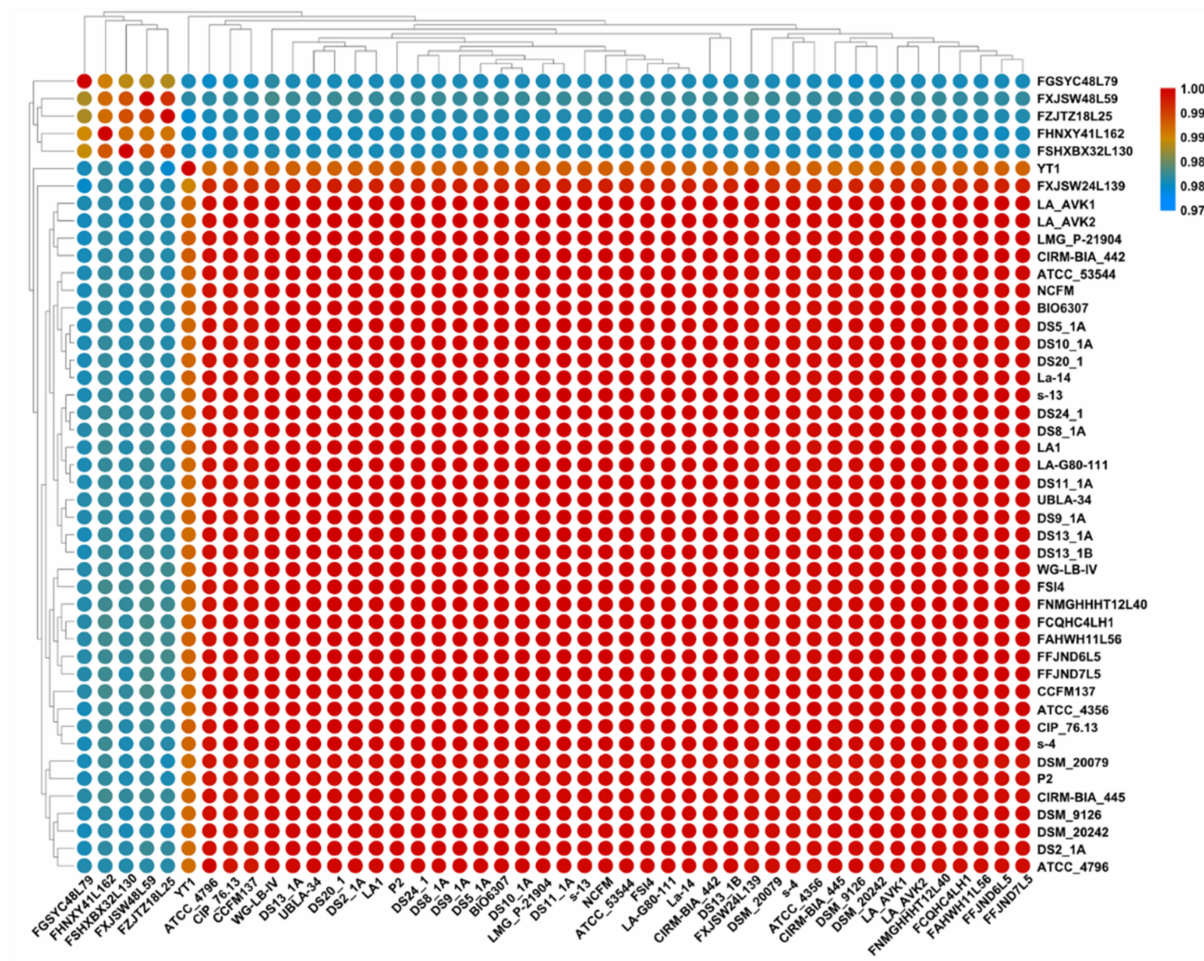
Figure 3. ANI Heatmap of L. acidophilus . Proposed species cut-off boundary is above 97%, showing identity within these